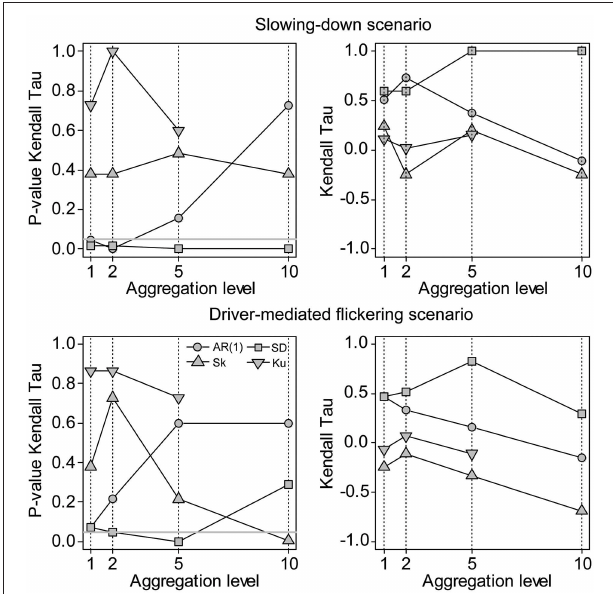
FIGURE 4 | Effect of data aggregation on the detection of four EWS patterns for the two scenarios using the block-based approach. Top : slowing-down scenario. Bottom : driver-mediated flickering scenario. For both scenarios, left panels show p -values and right panels show the estimates of Kendall rank correlation for mean EWS patterns obtained from 200 simulated time series. The gray lines indicate the threshold of P = 0 .05 under which correlations are considered significant. AR(1), autocorrelation; SD, standard deviation; Sk, skewness; Ku, kurtosis. Kurtosis could not be computed for aggregation 1 = 10 because of the lack of data for each block ( n = 3 ) for this aggregation level.